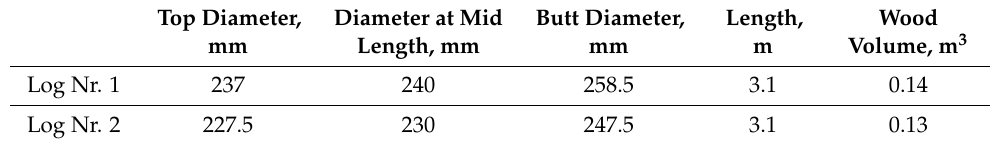
Table 2. Log dimensions (without bark).